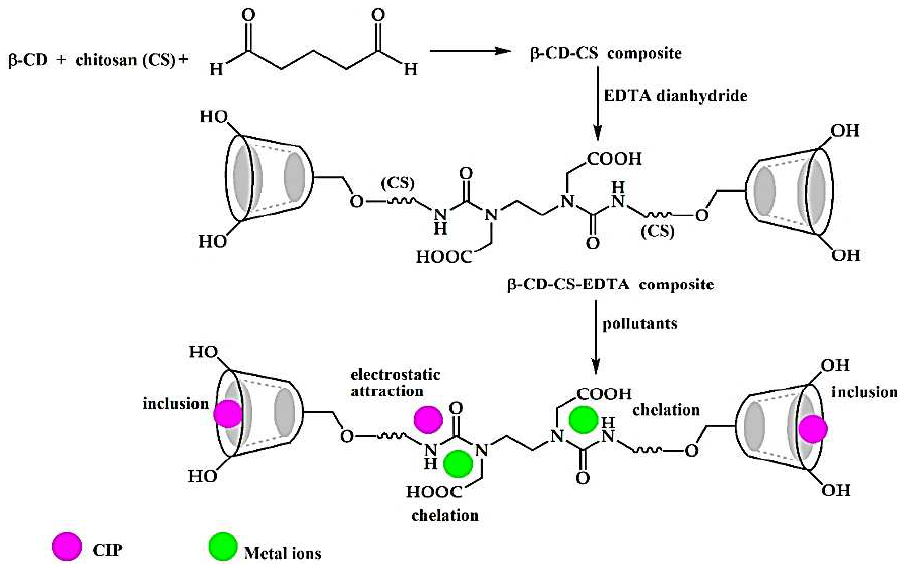
Figure 6. Schematic representation for the preparation of β-CD-Chitosan adsorbent [103]. Magnetic composites are frequently used in adsorption due to their strong hydrophilicity, greater surface area, and various active sites [104,105]. The addition of magnetic composite with poly (vinylidene fluoride) PVDF membranes is due to the characteristics mentioned above. Zhang et al. modified PVDF with β -CD/GO/Fe 3 O 4 to